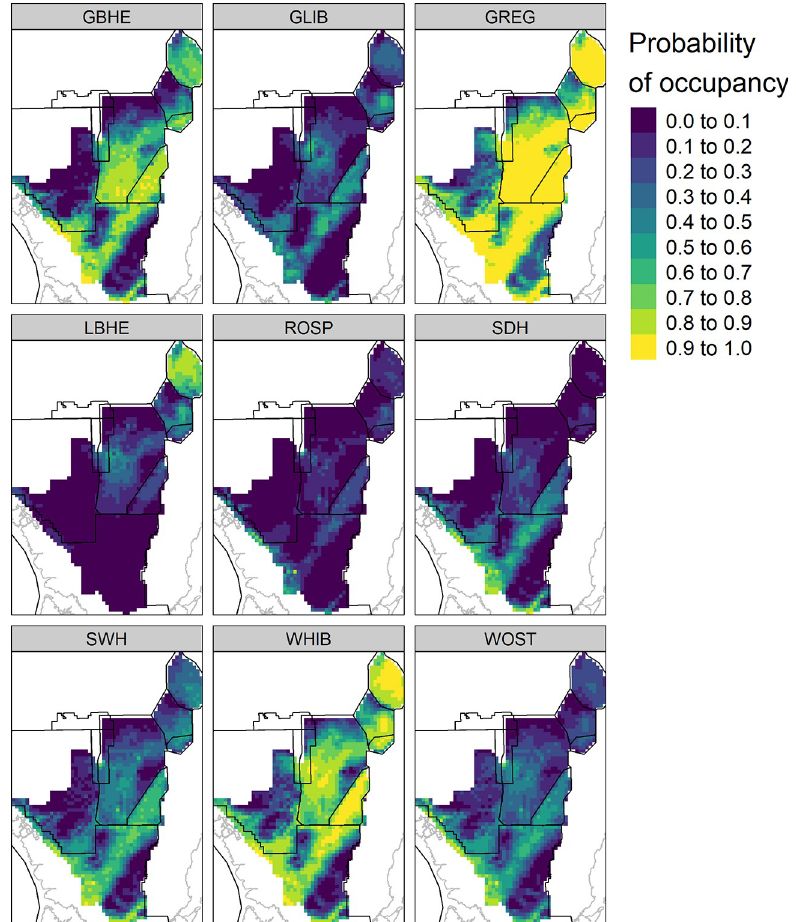
Fig 11. Example species-specific occupancy predictions. Species-specific predicted probabilities of occupancy across the Everglades landscape during 2009 calculated using the posterior mean of model parameters from a fitted joint species distribution model. Species are: GBHE (great blue heron); GLIB (glossy ibis); GREG (great egret); LBHE (little blue heron); ROSP (roseate spoonbill); SDH (small dark heron); SWH (small white heron); WHIB (white ibis); WOST (wood